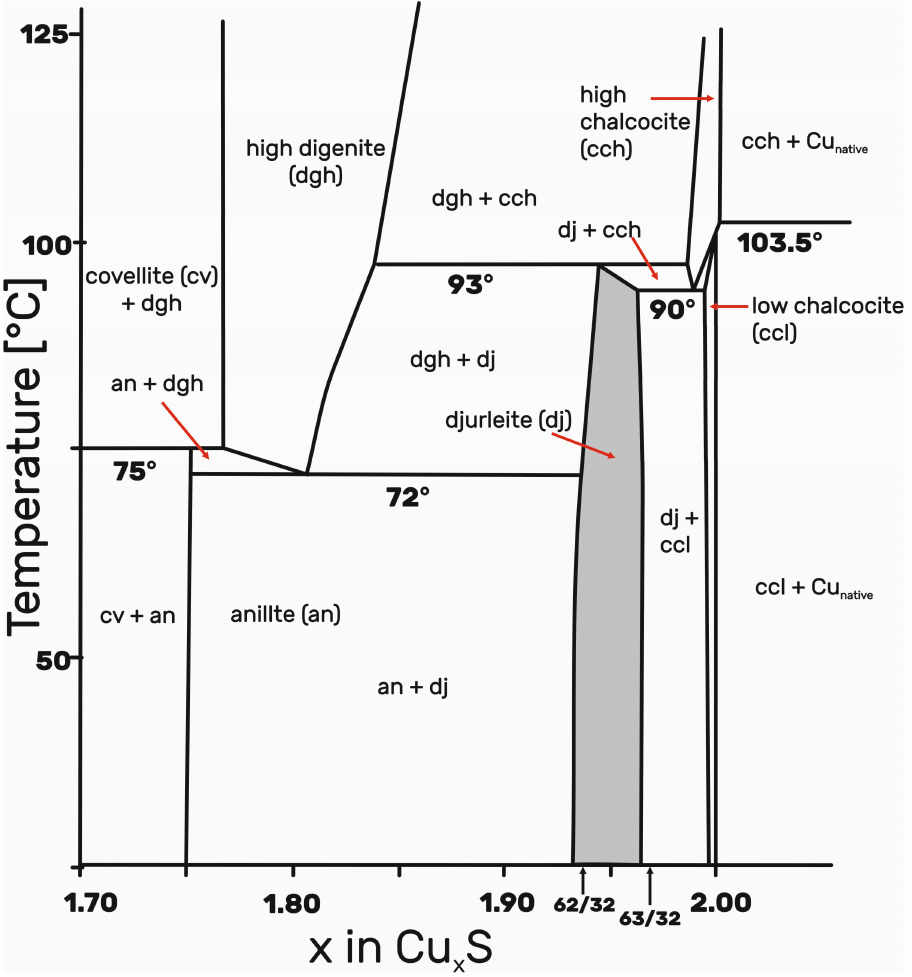
Figure 5. Phase diagram for the Cu-S system in the low temperature region near Cu 2 S from the literature [27]. The single djurleite area is